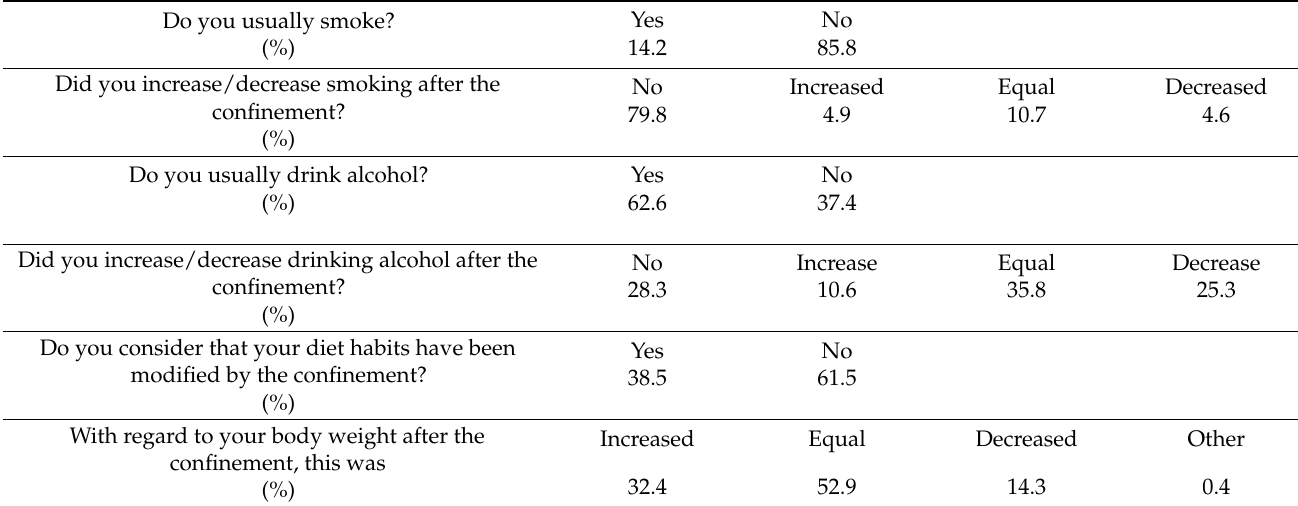
Table 5. Toxic habits (values are expressed as percentage).